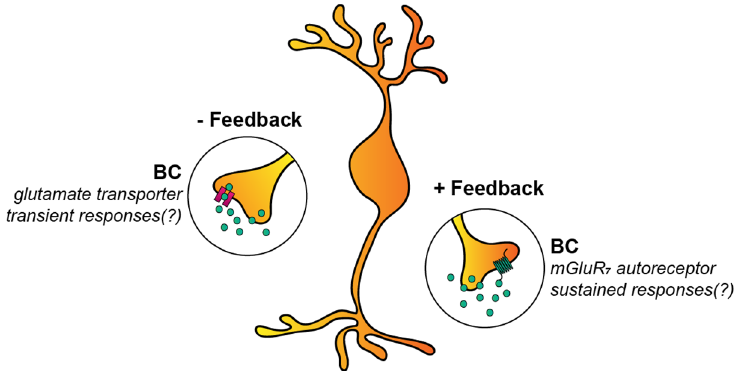
Figure 6. Self-regulation of bipolar cell responses. There are two identified mechanisms by which retinal bipolar cells (BCs) likely self-regulate their light responses. One of them takes place via glutamate transporters that sequester glutamate from the synaptic cleft, and thereby the effects of the transmitter and the light response become more transient (left panel). A second mechanism occurs through mGluR7 receptors that bind some of the released molecules and exert their effect on the dynamics of release and the light response itself (right panel). The net effect of the activation of mGluR7 receptors in the BC axon terminals makes BC responses more sustained (also see the